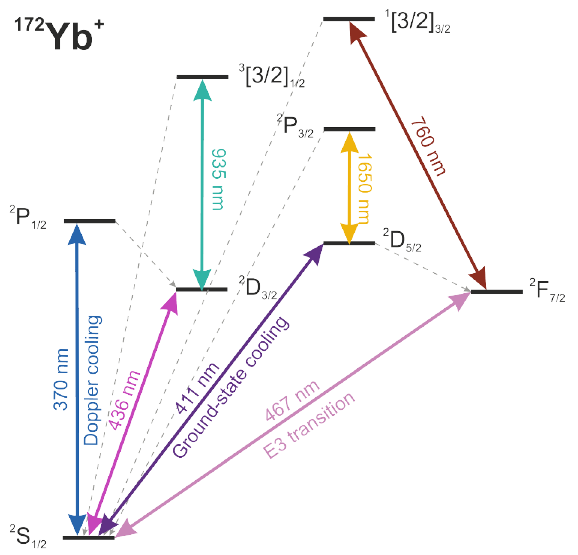
Figure 3. Level scheme of 172 Yb + ions with all relevant tran- sition wavelengths for our integrated optics. We use 172 Yb as a testbed for other future ion elements.